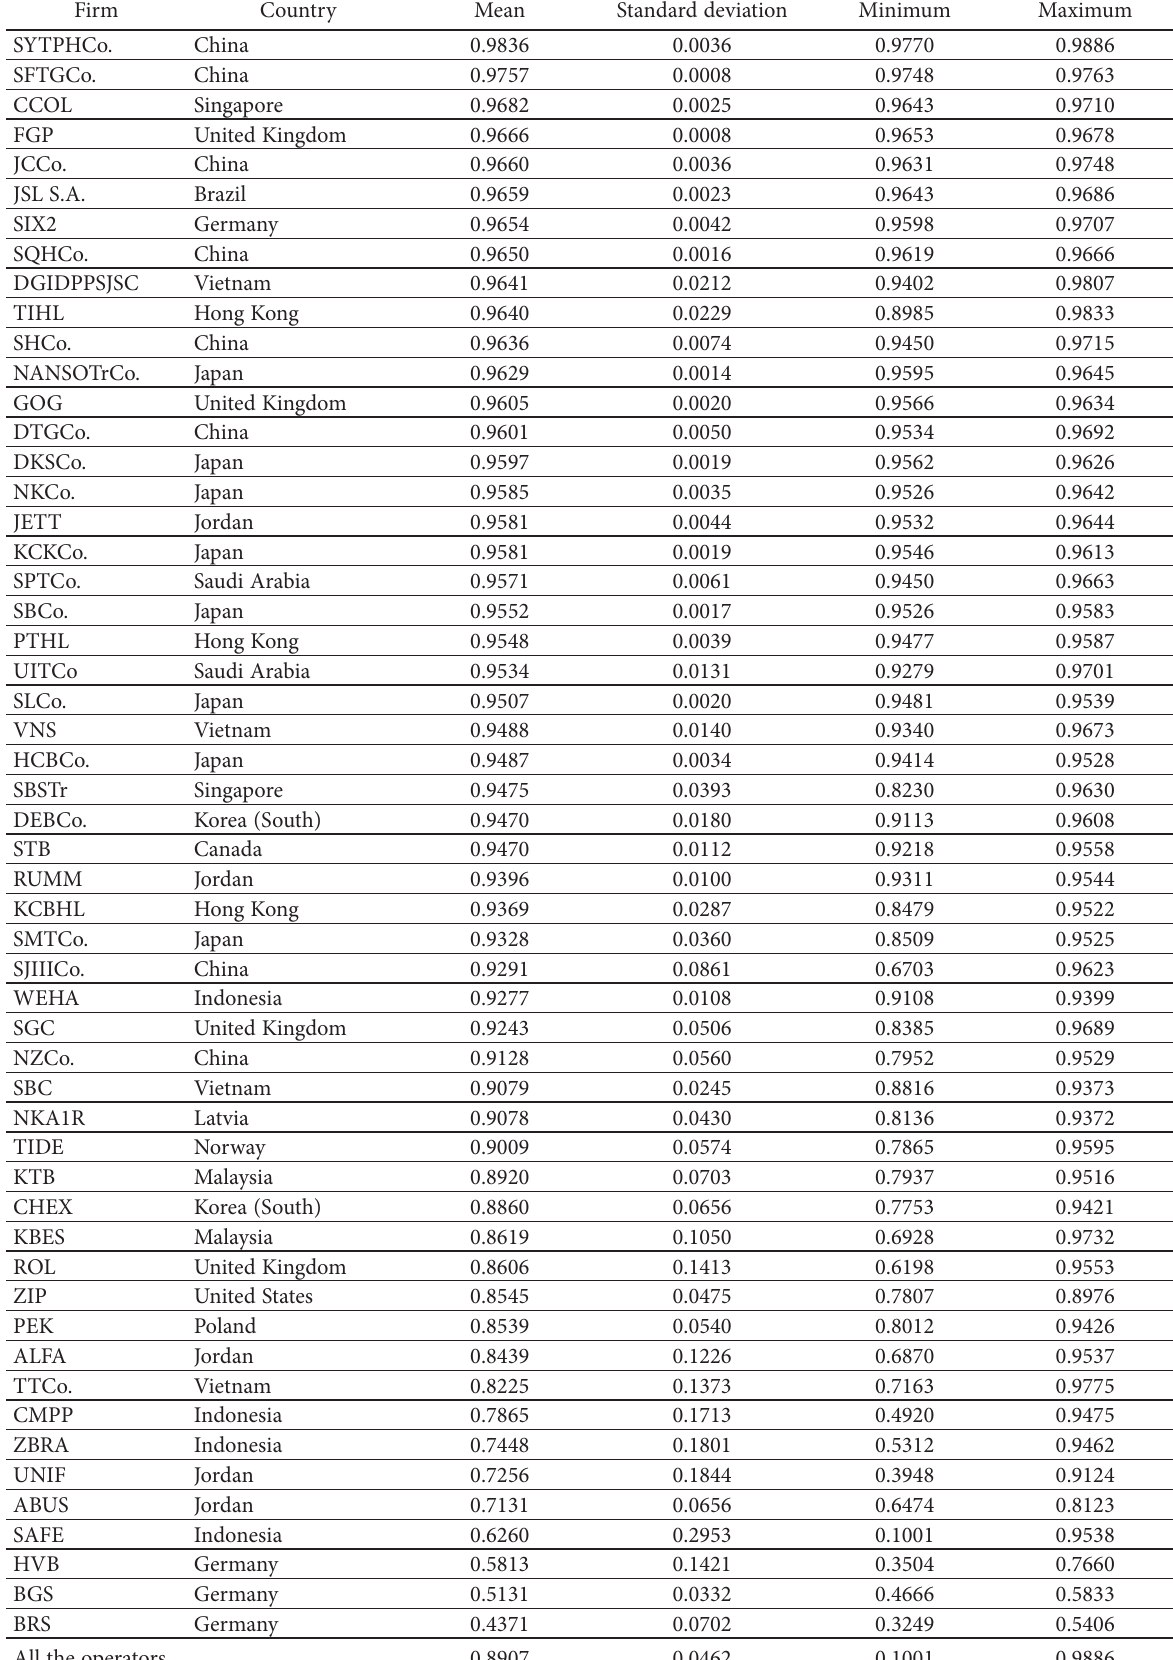
Table 4. Technical efficiency of public road transport by